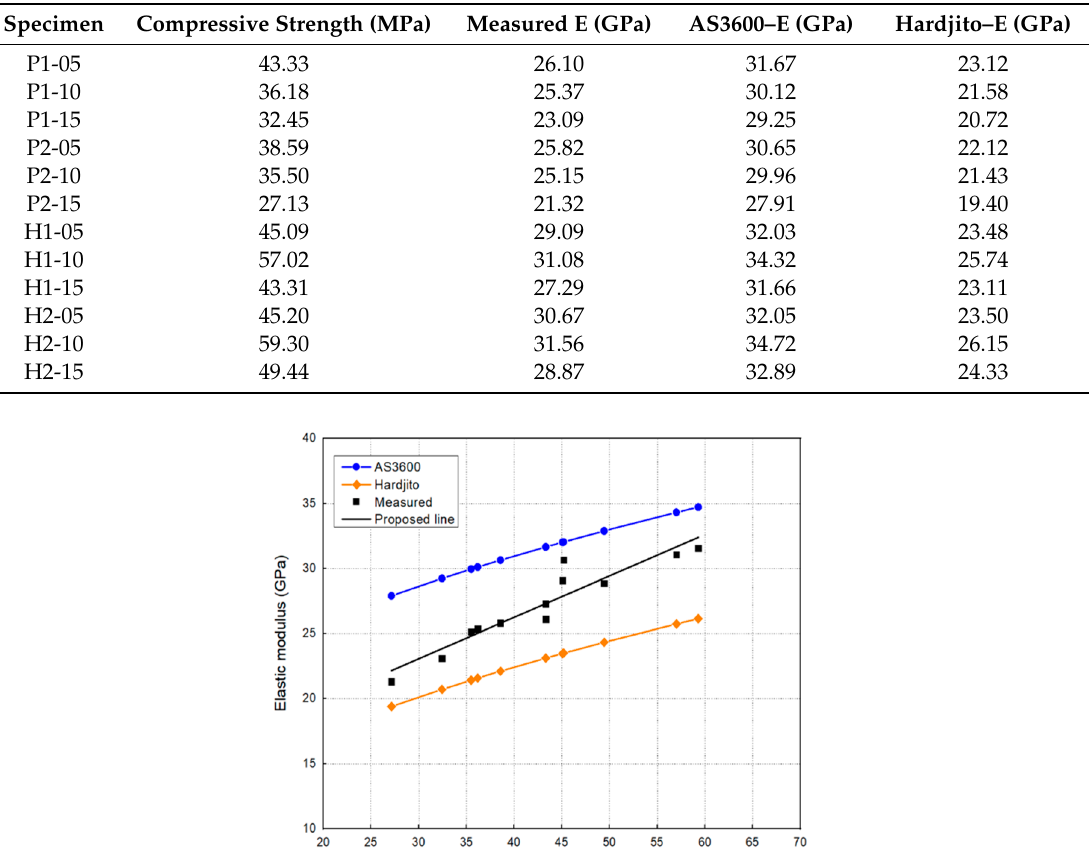
Table 7. Comparison of elastic modulus.